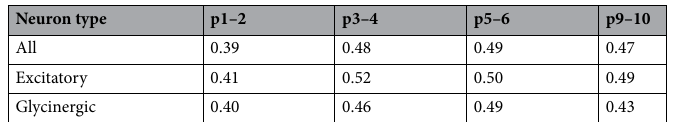
Table 2. Median maxCC of inspiratory neurons. Data are shown as median maxCC of inspiratory neurons belonging to each neuron type. Group of “all” includes inspiratory excitatory, glycinergic, GABAergic and GGC